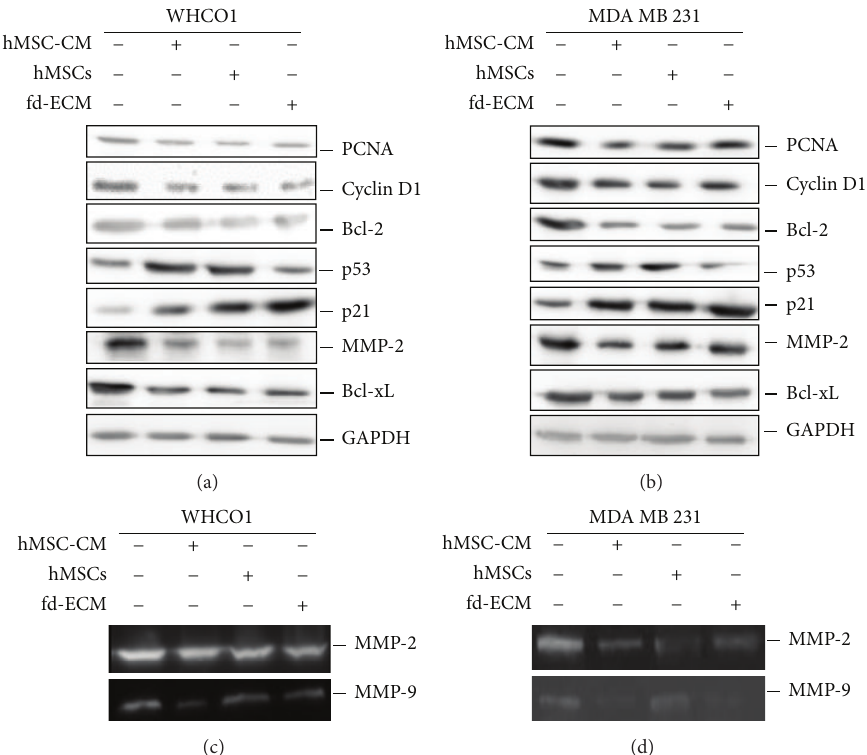
Figure 2: MSCs and fd-ECM inhibit cellular gene expression in WHCO1 and MDA MD 231 cells. (a) Western blot analysis of lysates from WHCO1 cells cocultured with MSCs or cultured on an fd-ECM for 48hrs showing expression of PCNA, cyclin D1, Bcl-2, p53, p21, MMP-2, MMP-9, and Bcl-xL. (b) Western blot analysis of lysates from MDA MB 231 cells cocultured with MSCs or cultured on an fd-ECM for 48 hrs showing expression of the same genes as in (a). Glyceraldehyde 3-phosphate dehydrogenase (GAPDH) was used as a loading control. ((c)- (d)) MMP-2 and MMP-9 gelatinolytic activities in WHCO1 (c) and MDA MB 231 (d) in media samples after 48 hrs of incubation at 37 ∘ C as described in Section 2. Gelatinolytic activity was observed as clear bands in the gels. Experiments were performed in triplicate and repeated 3